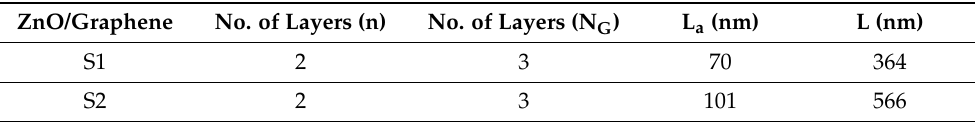
Table 1. Number of layers per graphene flakes, Lateral Size (L), and Crystallite size (L a ) of ZnO/graphene nanocomposites. ZnO/Graphene No. of Layers (n) No. of Layers (N G ) L a (nm) L (nm) S1 S2